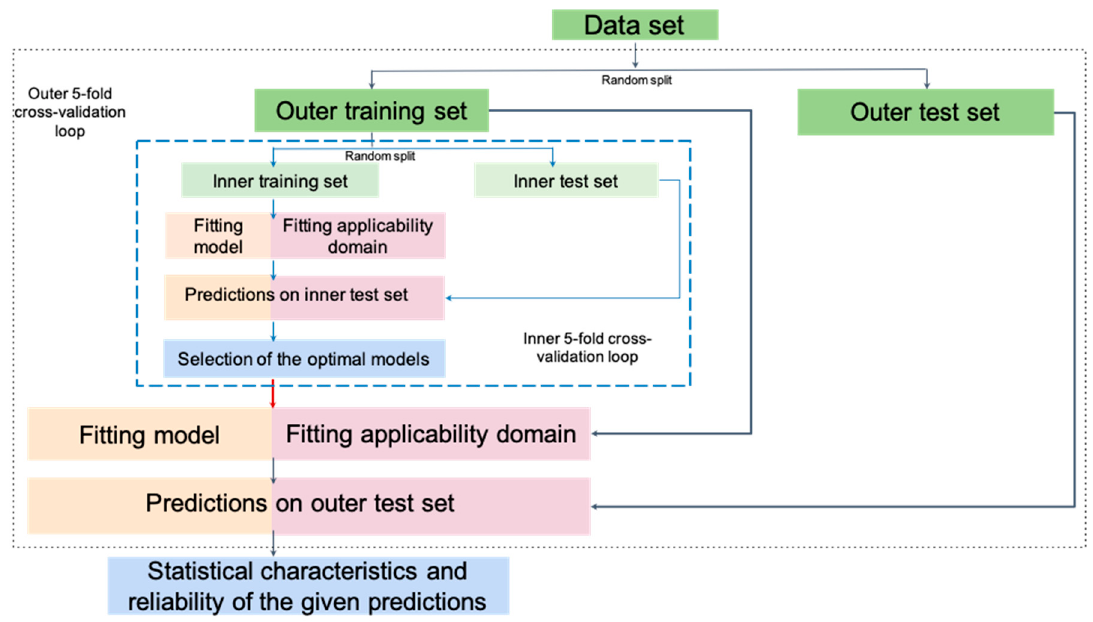
Figure 2. The procedure for selecting the hyperparameters of Quantitative Reaction–Property Relationships (QRPR) and the AD definition models.